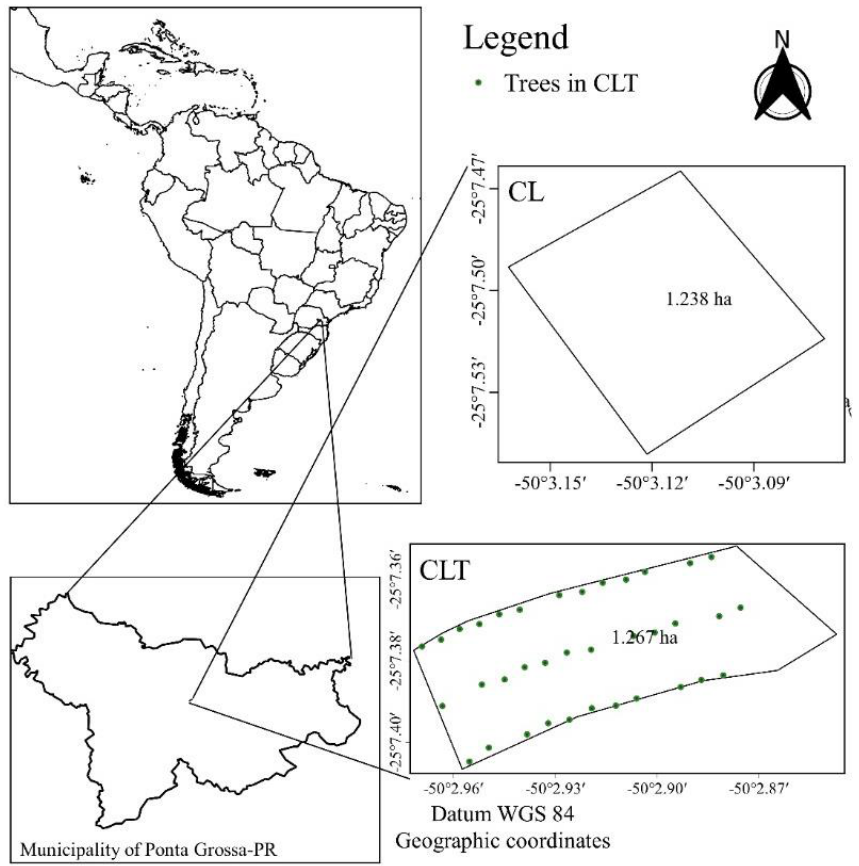
Figure 1. The experimental site at Ponta Grossa, Paraná, Brazil. CL: crop–livestock only; and CLT: crop–livestock with trees.